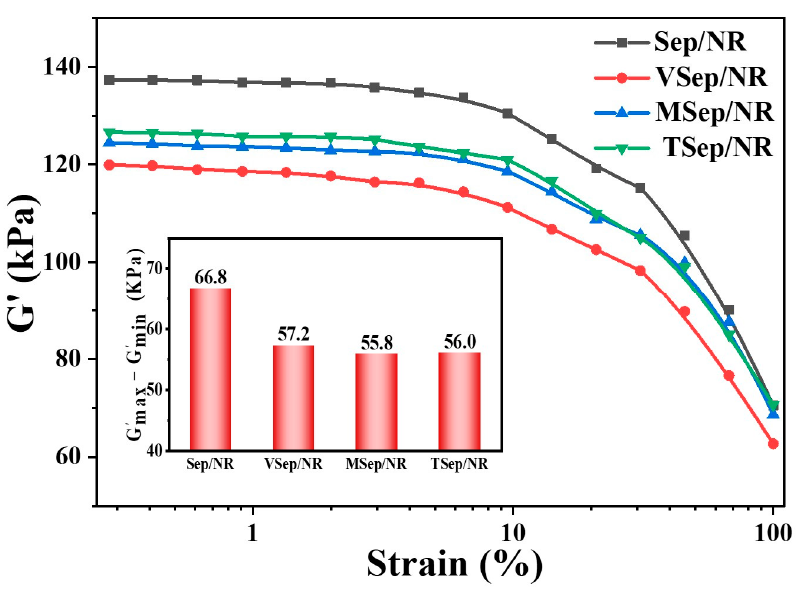
Figure 5. Strain amplitude dependence of the storage modulus (G’) of sepiolite/NR composites .